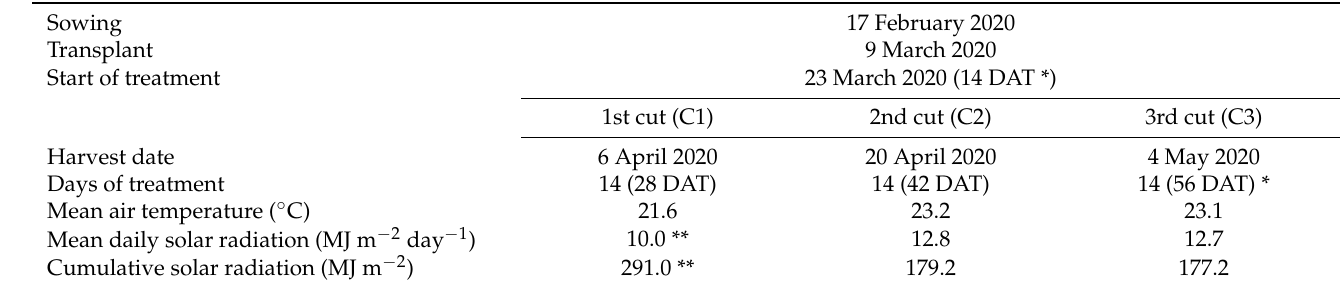
Table 1. Basic information on the experiment with Swiss chard and sea beet grown hydroponically under